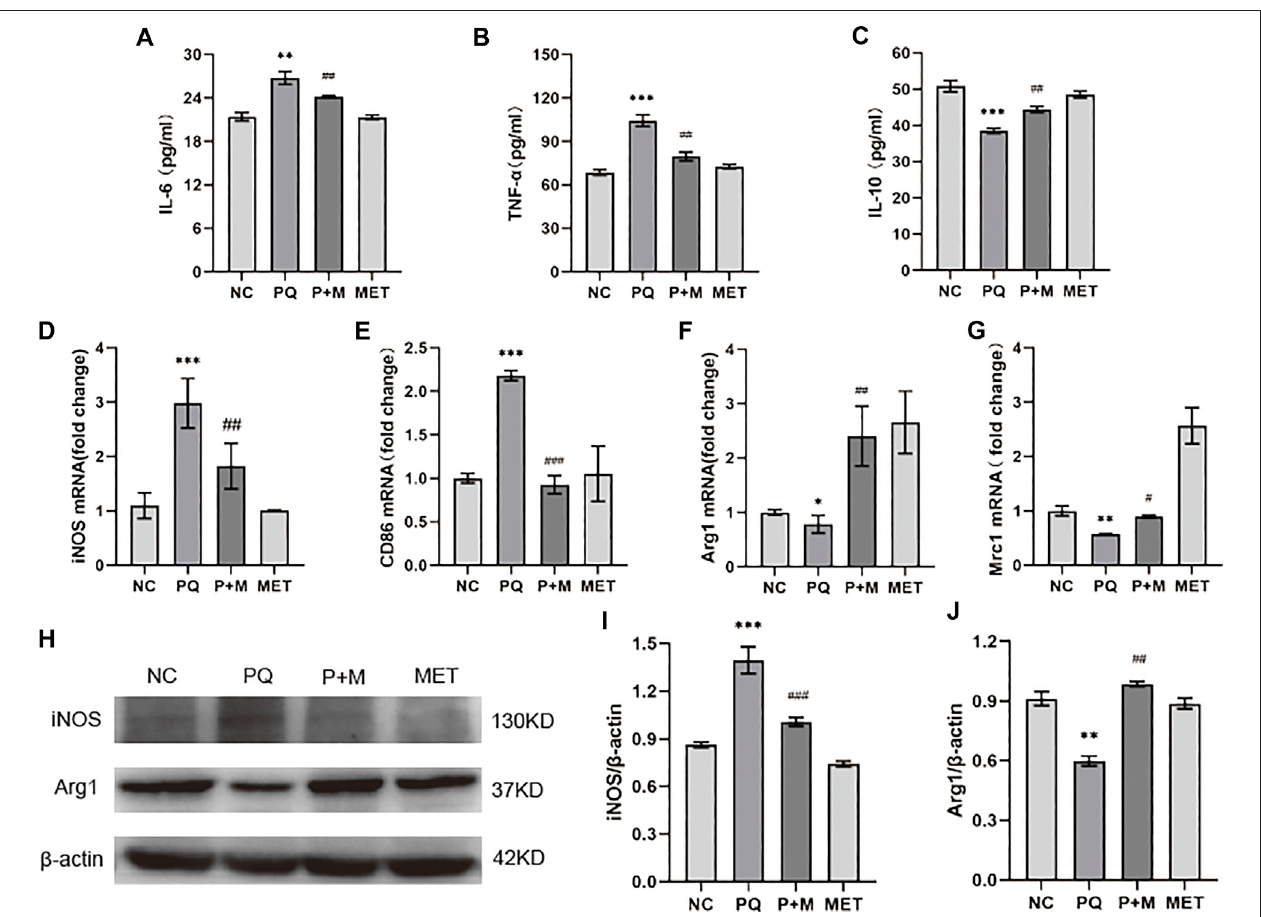
FIGURE 5 | The effect of MET on the polarization of PQ-induced NR8383. ELISA kits detect the levels of IL-6 (A) , TNF- α (B) , and IL-10 (C) in the cell supernatant ( n =3);mRNAexpressionlevelsofiNOS (D) ,CD86 (E) ,Arg1 (F) ,Mrc1 (G) incells( n =3); (H) proteinexpression levelsofiNOS (I) ,Arg1 (J) incells( n =3).Comparedwith the NC group, * p < 0.05, ** p < 0.01, *** p < 0.001; compared with the PQ group, # p < 0.05, ## p < 0.01, ### p < 0.001.